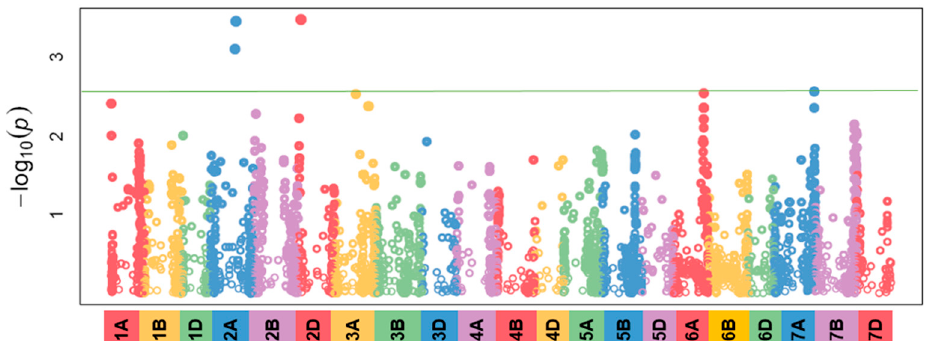
Figure 5. Manhattan plot, average AUDPC values under field conditions, according to the chromosomal localization of the markers (level of significance: -log 10 ( p ) 2,5; Martonvásár 2006, 2009, 2011).